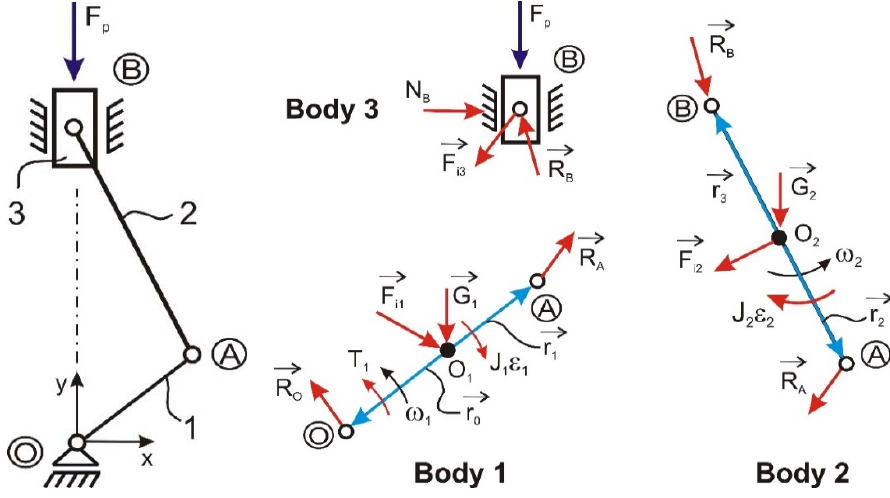
Figure 8. Free body diagram for the classical mechanism.